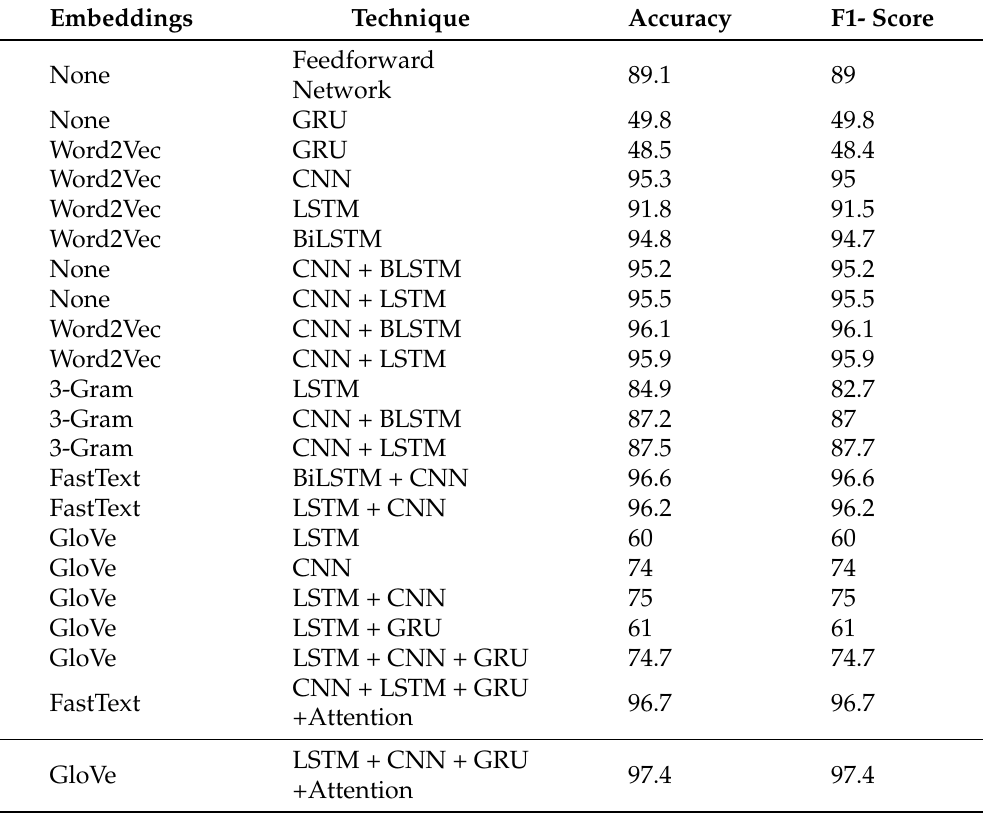
Table 12. Experimental analysis of deep learning models on binary labeled Data Section 4.2.1.